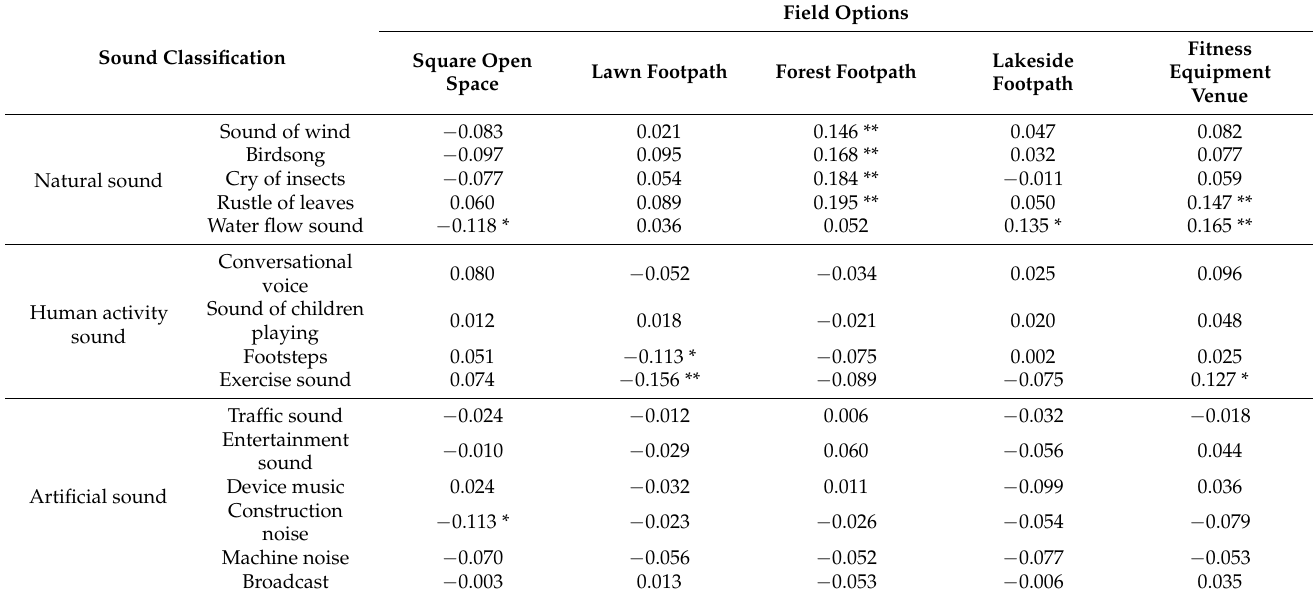
Table 3. Correlation between different exercise site selections and soundscape